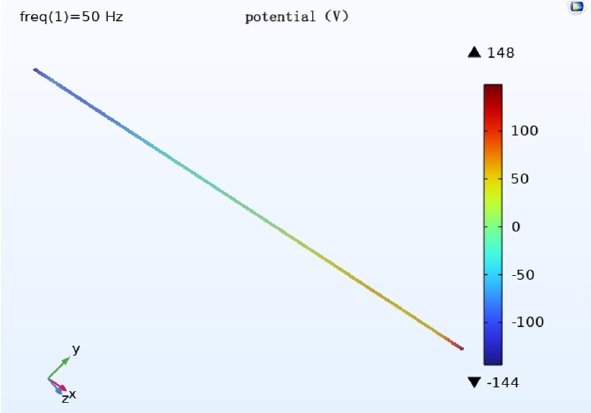
Figure 15. Distribution of cathodic protection potential when the parallel spacing is 25 m.